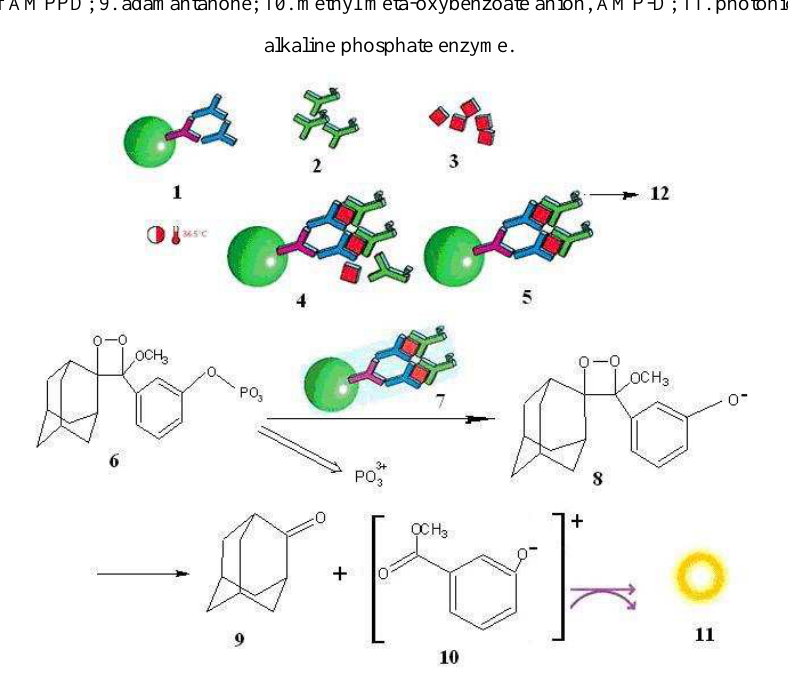
Scheme 4. diagram of ECLIA based on superparamagnetic polymer